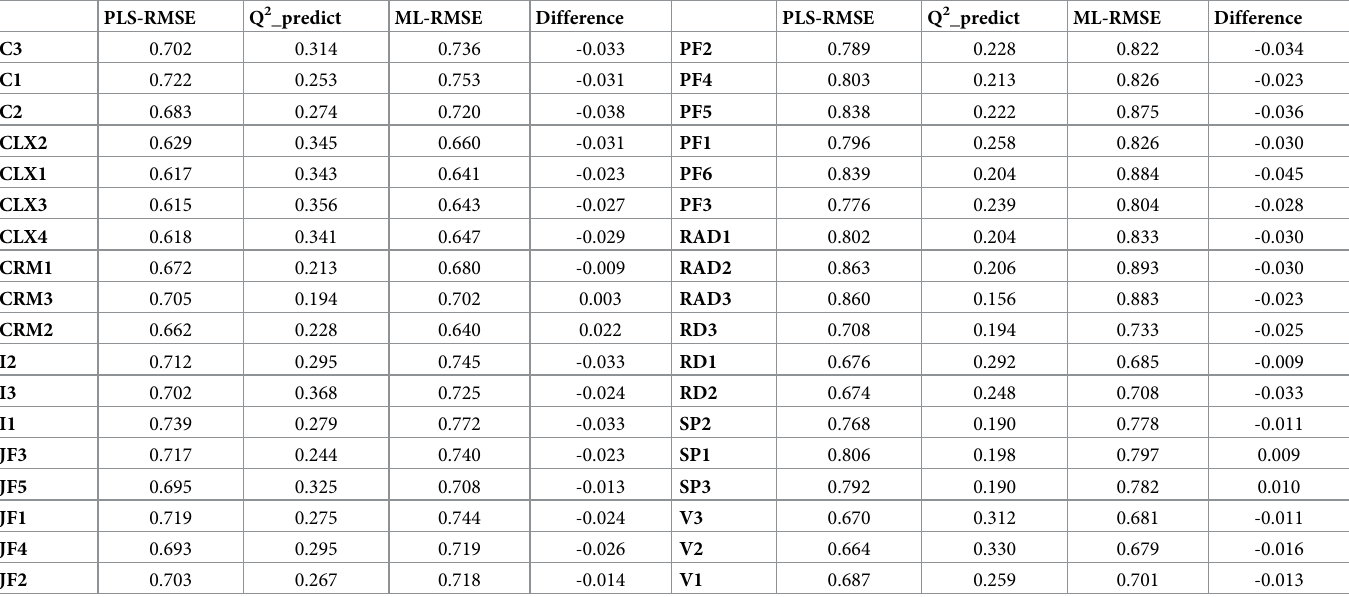
Table 7. Results of PLS predict